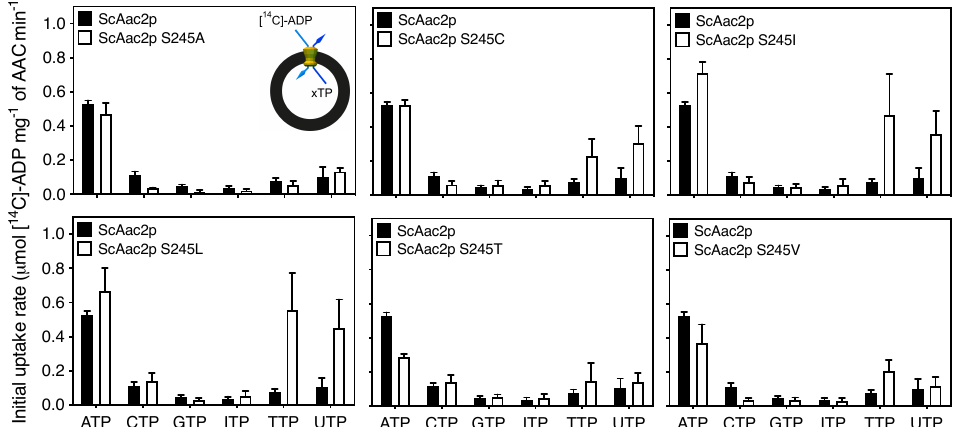
Figure 8. Nucleotide hetero-exchange by wild-type and S245 mutants of ScAac2p. Vesicles of lactococcal membranes expressing wild-type ScAac2p (black bars) or mutant carriers at position S245 (white bars) were loaded with 2.5 mM ATP, CTP, GTP, ITP, TTP, or UTP, and transport was initiated with the external addition of 1.5 µ M [ 14 C]-ADP. The specific initial transport rates were determined over the linear part of the uptake curve, typically in the first 60 s. Data are represented by the mean and standard deviation of two biological repeats with six technical repeats in